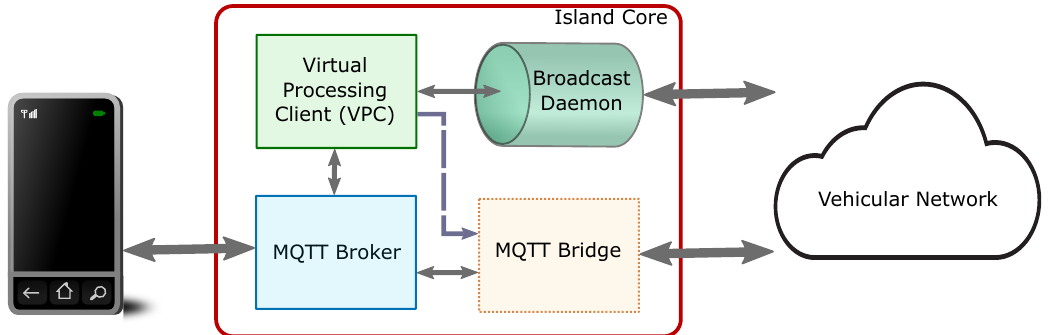
Figure 2. Functional components of the Island Core used by the FCW